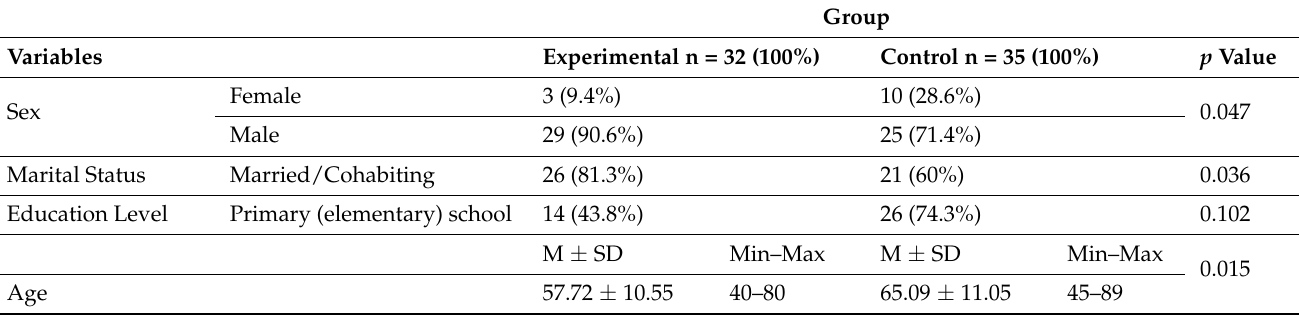
Table 3. Sociodemographic